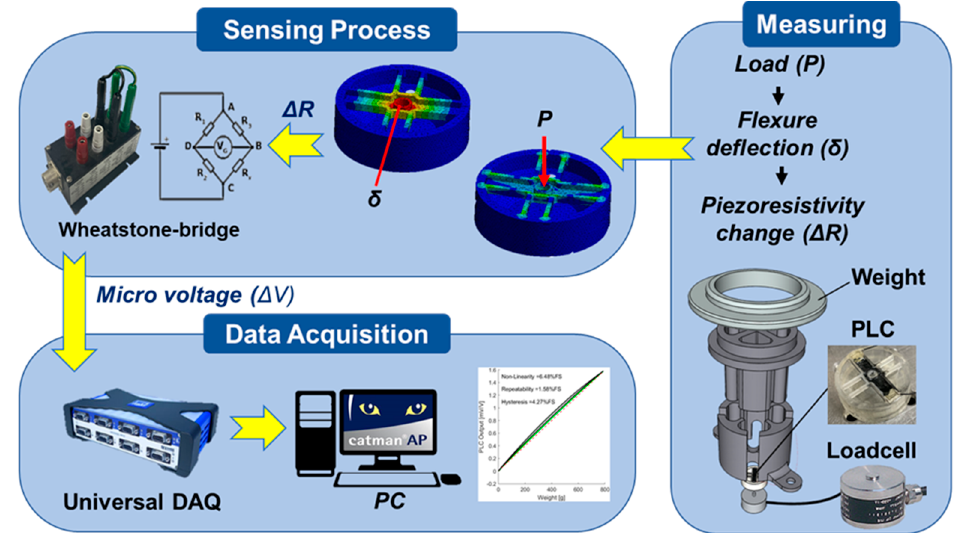
Figure 5. Schematic illustration of the 3D printing load cell sensing characteristics measurement setup.